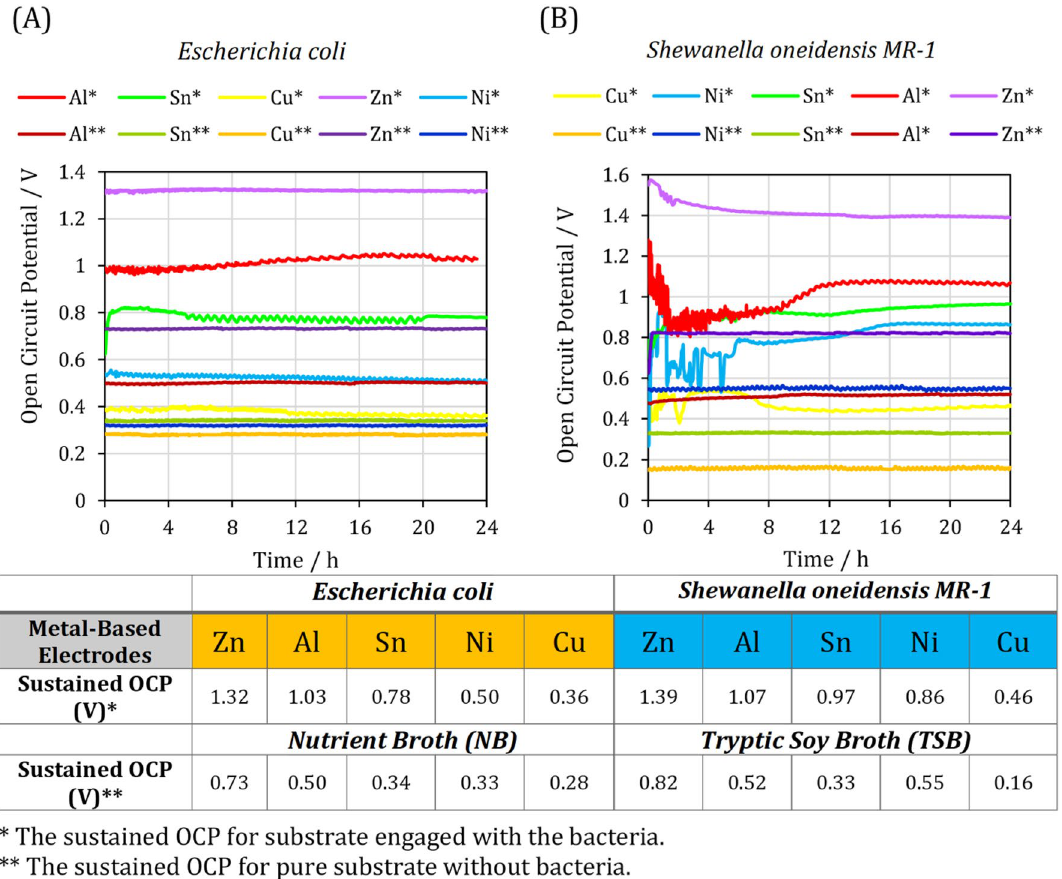
Figure 2. The open circuit potential (OCP) evolution of zinc, aluminum, tin, copper and nickel anode electrodes with ( A ) Escherichia coli and ( B ) Shewanella oneidensis MR-1 microorganisms and pure